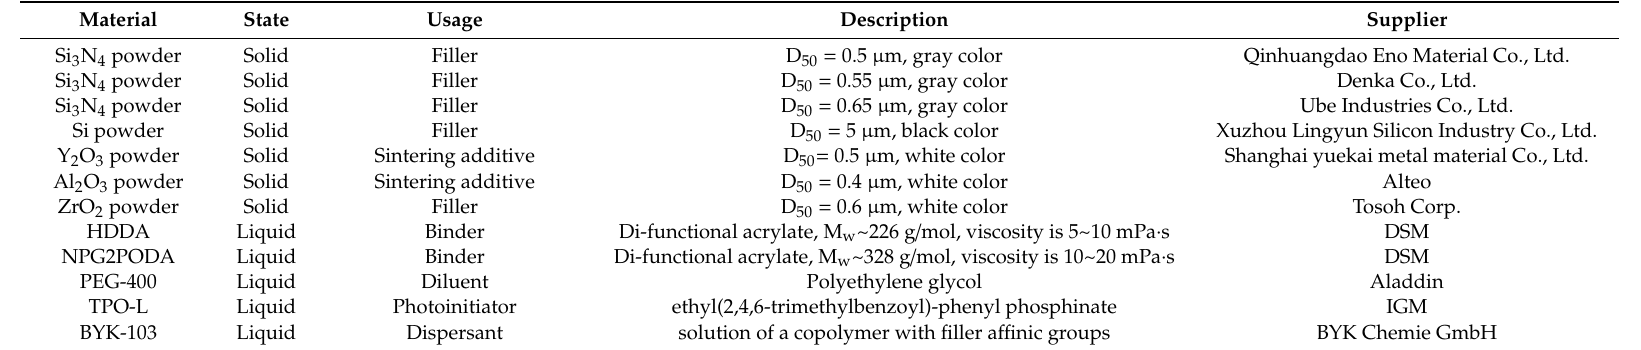
Table 1. Data of the raw